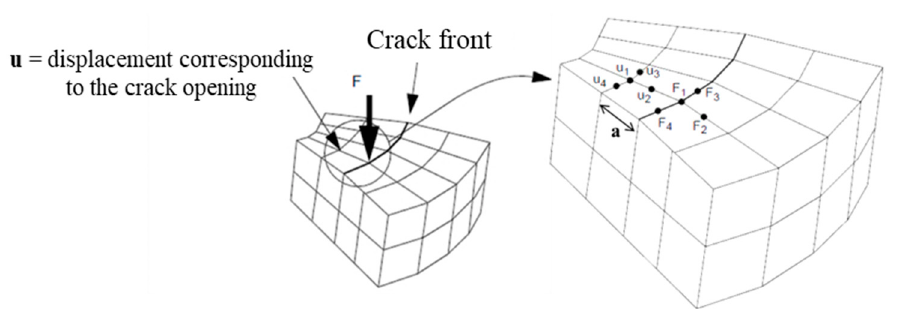
Figure 5. Determination of the energy release rate in 3D modeling [39].